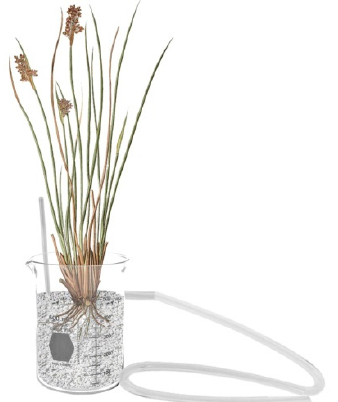
Figure 1. Schematic representation of the CW-microcosm with J. acutus plant and gravel as substrate. The pipette on the left allows to introduce the contaminated irrigation solution into the beaker and the tube on the right allows to collect the microcosm effluent for further analyses.